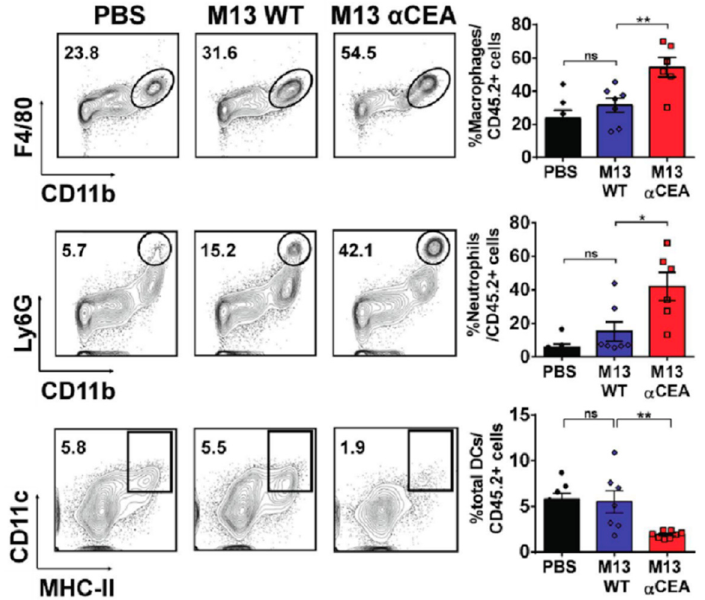
Figure 4. Treating the tumor microenvironment using PBS, wild type M13 bacteriophage, and α CEA-M13 bacteriophages for 24 h. Contour plots shows tumor infiltrating macrophages (F4/80 + CD11b + ), ( upper left ), neutrophils (CD11b + Ly6G high ), ( middle left ), and dendritic cells (CD11c + MHC-II + ), ( lower left ). The percentage of each plot ( right-hand panel ). Reproduced from [44], with permission from Springer Nature, 2017.